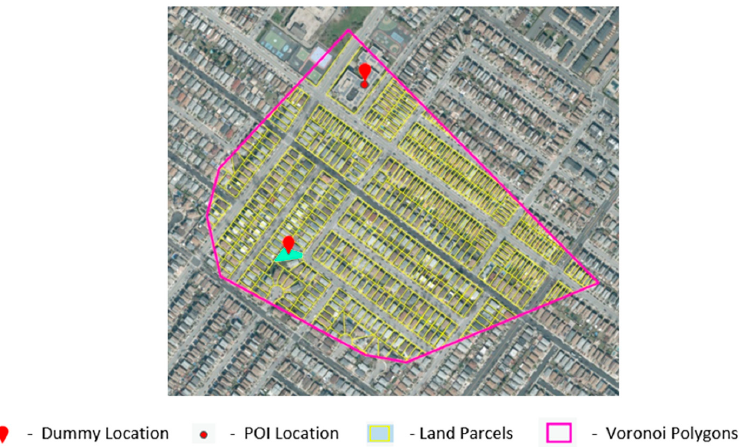
Figure 4. Voronoi parcel similar to v true from cosine similarity search, residential parcel prclSim 1 sim-